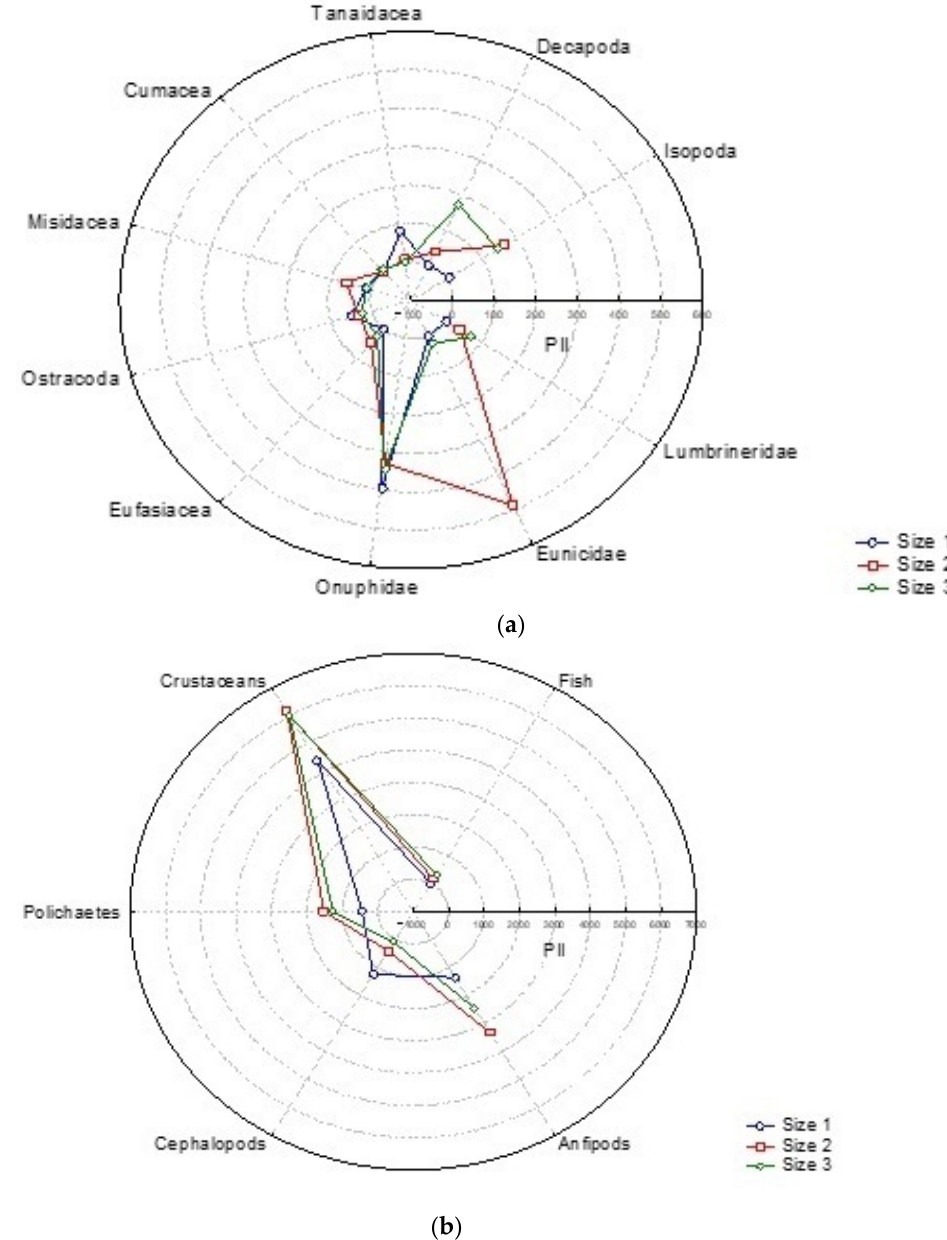
Figure 4. Polar representations of the variation with the size of prey importance index (PII) of prey identified at the micro-taxa level ( a ) (amphipods, isopods, mysids, decapods, tanaids, ostracods, euphausids, cumaceans, onuphids, eunicids and lumbrinerids) and macro-taxa level ( b ) (fish, crustaceans, polychaetes and cephalopods); in the stomachs of sample of C. caelorhincus from Central Thyrrhenian sea. Sizes (1, 2, 3) are for smallest, intermediate, and largest size classes, respectively. Amphipods are represented in plot ( b ) due to the scale of their PPI .